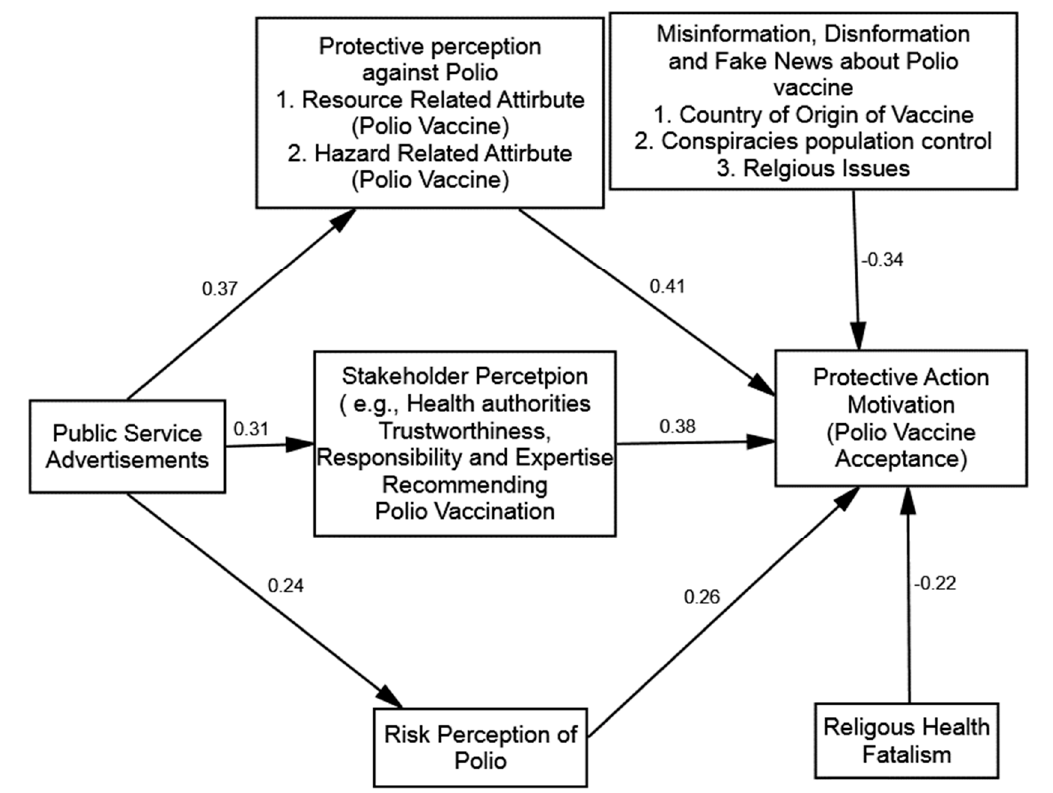
Figure 3. Structural model.